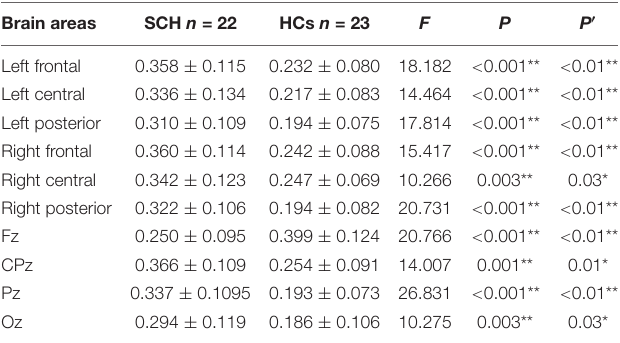
TABLE 3 | Comparison of theta power between schizophrenia and controls with eyes closed. Brain areas